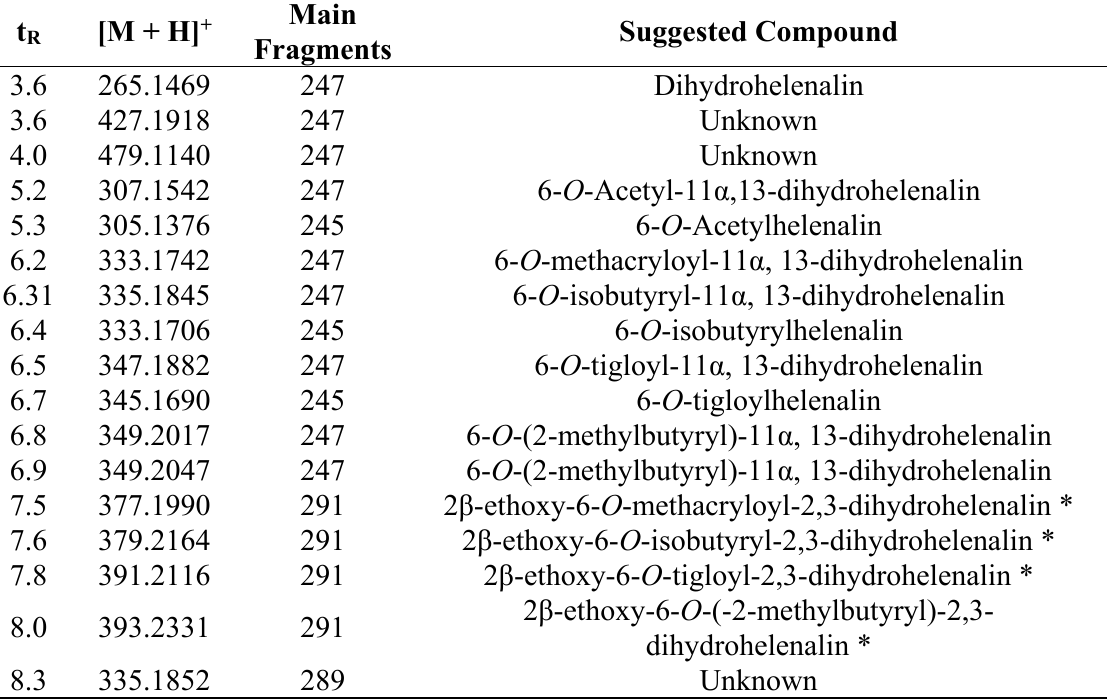
Figure A6. ID_55. Extract of Arnica montana L. Table A8. Dereplication results for